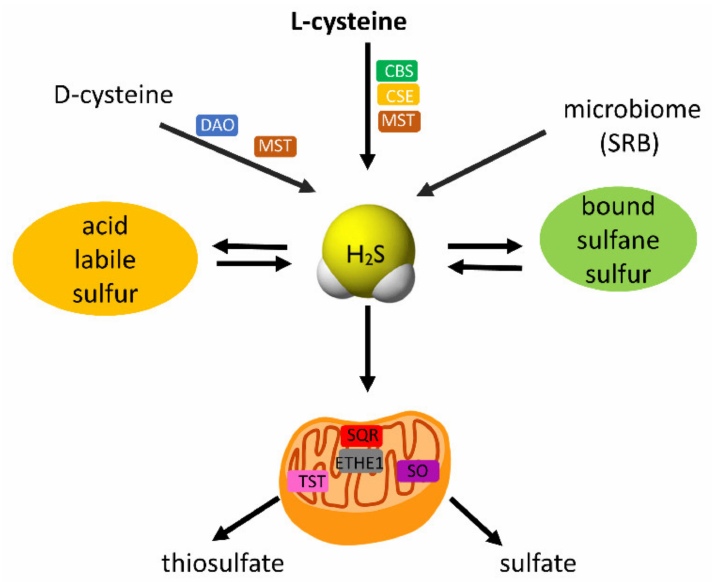
Figure 4. Synthesis and mitochondrial catabolism of H 2 S. H 2 S is synthesized in most tissues from L-cysteine in reactions catalyzed by cystathionine β -synthase (CBS), cystathionine γ -lyase (CSE), and 3-mercaptopyruvate sulfurtransferase (MST). In peroxisomes, H 2 S can be formed from D-cysteine with participation of D-amino acid oxidase (DAO) and then with MST. Another source of H2S in humans is derived from microbiome-containing sulfate-reducing bacteria (SRB). H 2 S coexists in biological conditions in equilibrium with a pool of reactive sulfur, namely bound sulfane sulfur (mainly persulfides and polysulfides) and acid-labile sulfur (mainly iron–sulfur clusters).